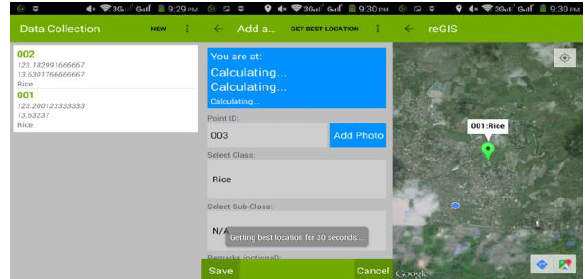
Figure 6. AdNU’s reGIS app for field data